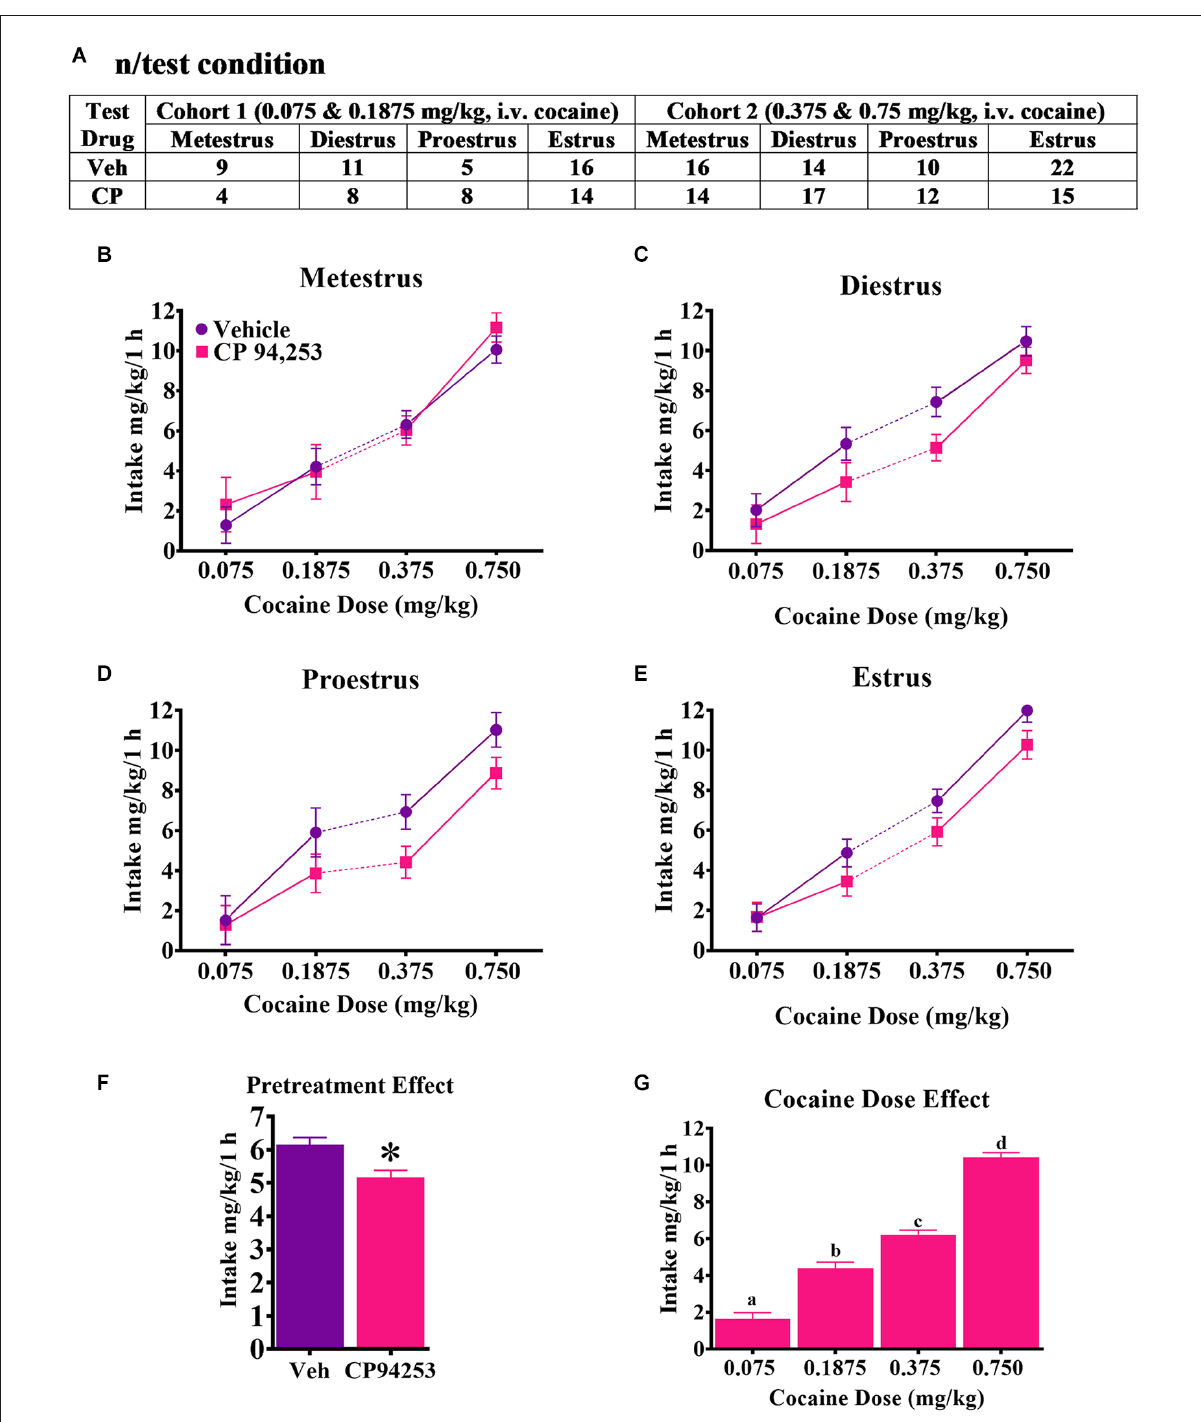
FIGURE2 The number of rats tested in each condition under an FR5 reinforcement schedule (A) and effects of CP94253 on their mg/kg cocaine intake (mean ± SEM) during metestrus (B) , diestrus (C) , proestrus (D) and estrus (E) . Cohort 1 had access to 0.075 and 0.1875 mg/kg, i.v. cocaine in descending order during the test phase of the experiment whereas cohort 2 had access to 0.375 and 0.75 mg/kg, i.v. cocaine in descending order. For subjects tested more than once under the same condition due to mis-predicted estrous cycle phase, the average of the tests was used in the ANOVA. There were no effects nor interactions with the estrous cycle phase. A main effect of pretreatment (F) indicated less mg/kg cocaine intake after CP94253 pretreatment compared to the vehicle regardless of cocaine dose and a main effect of dose indicated that rats consumed more cocaine as the dose available increased (G) . ∗ Indicates a significant difference from the vehicle, ANOVA main effect, p < 0.05. “a”, “b”, “c”, and “d” letter symbols indicate a significant difference from each other, Bonferroni t -tests, p <